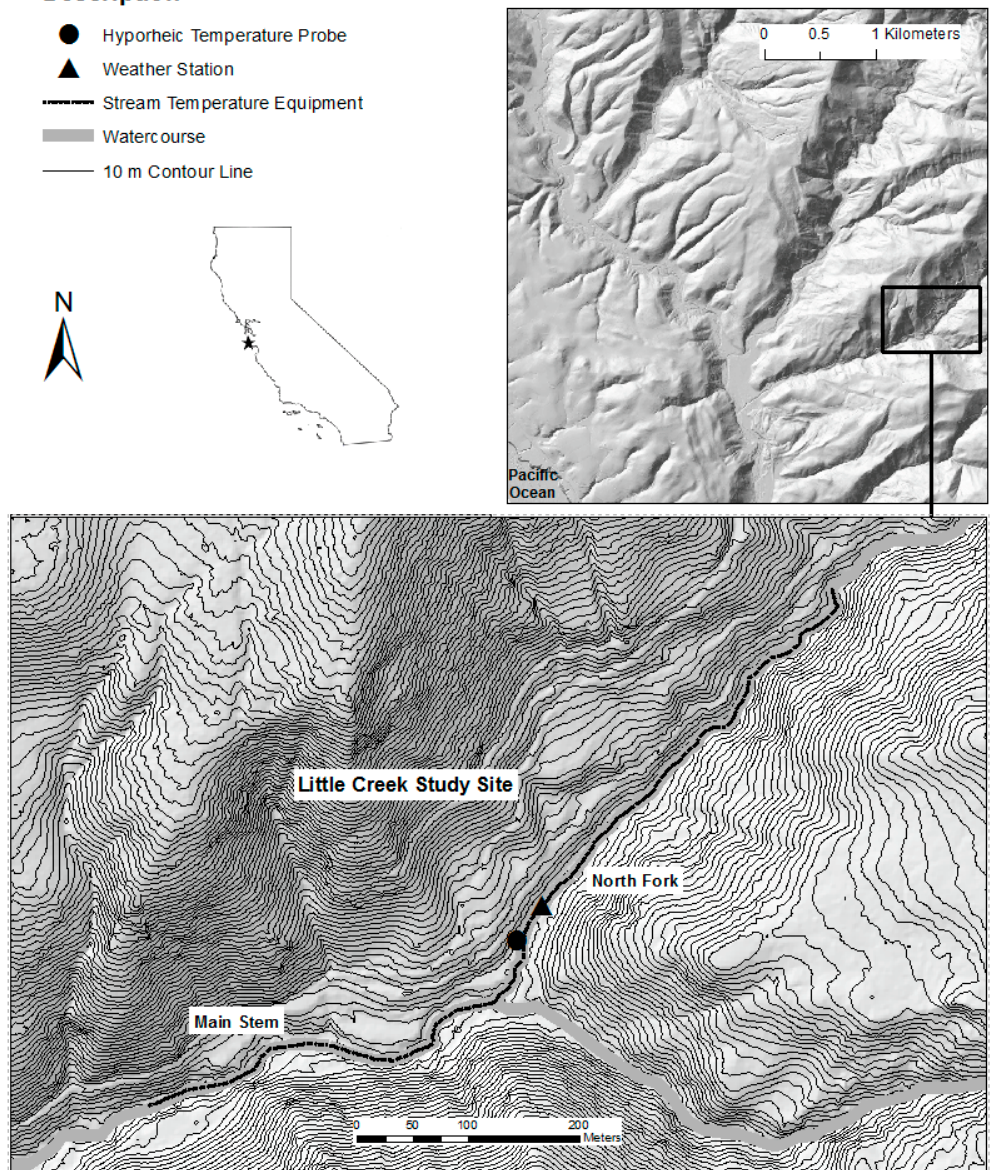
Figure 1. Little Creek study site location, Santa Cruz County, CA, USA.